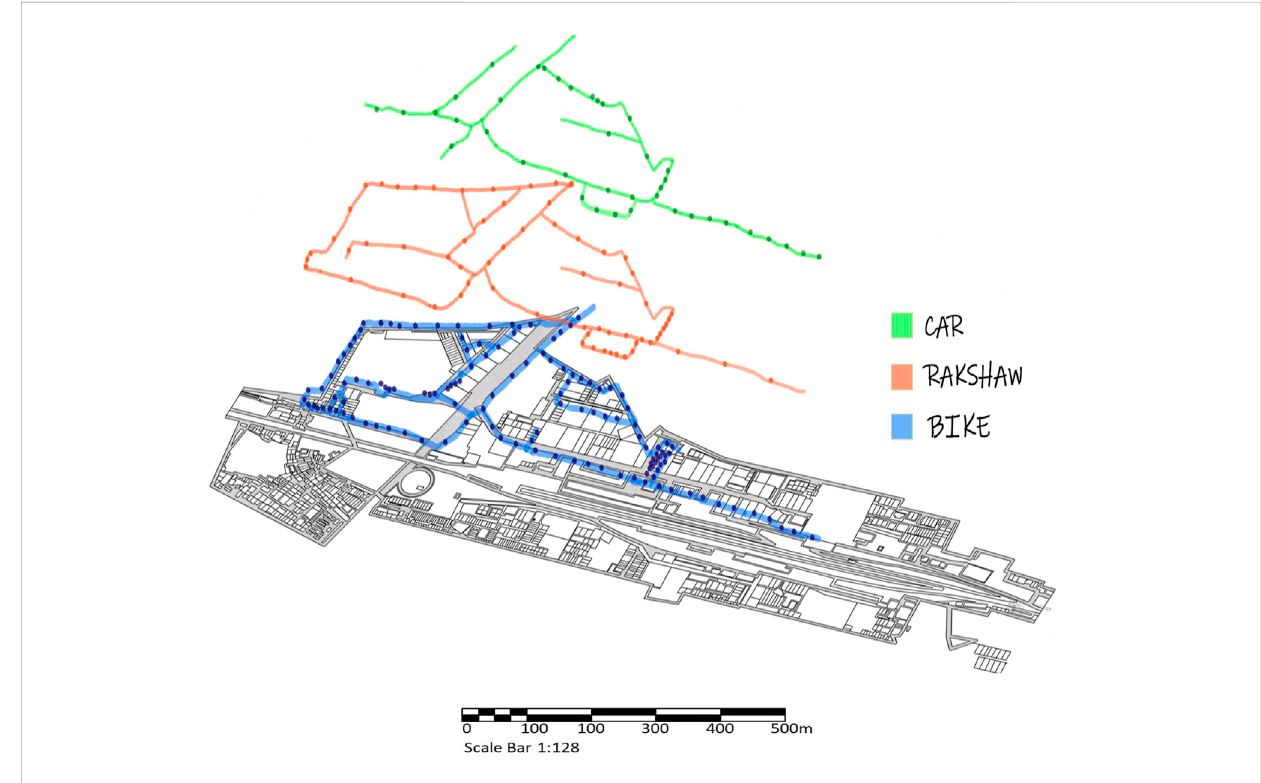
Traf fi c fl ow